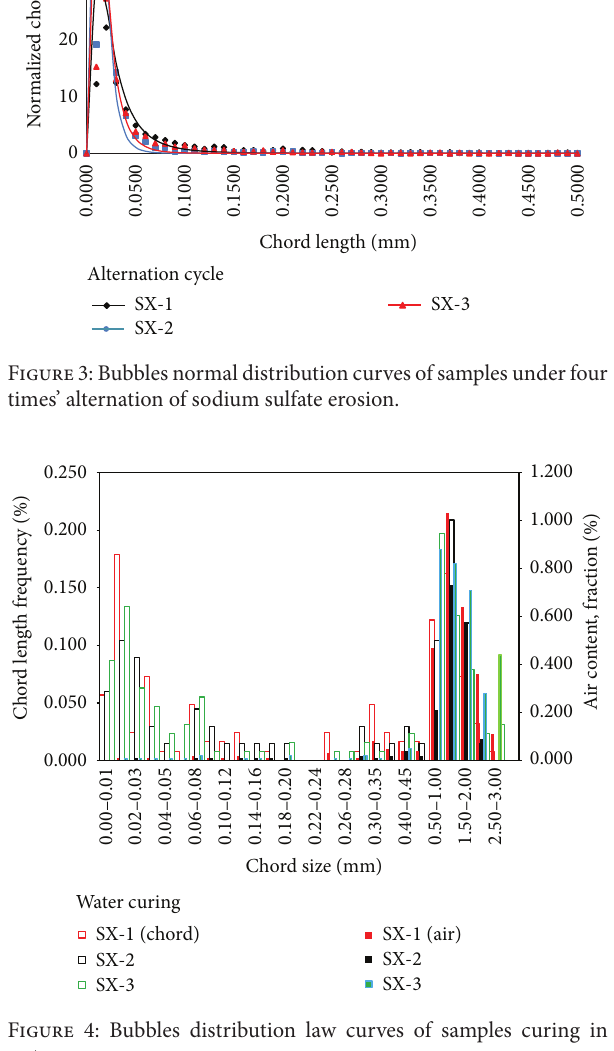
Figure 4: Bubbles distribution law curves of samples curing in